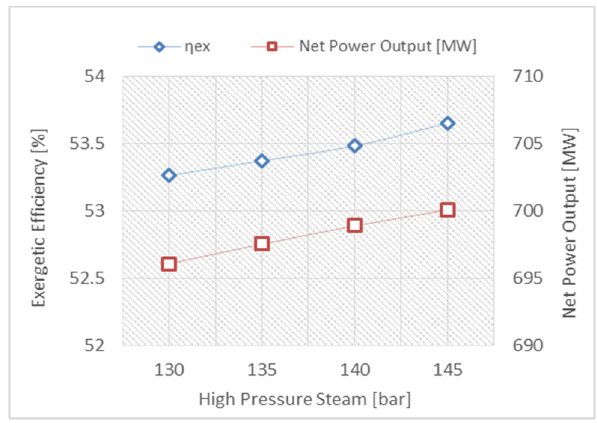
Figure 6. Exergetic efficiency and block net power output versus high pressure steam in HRSG.